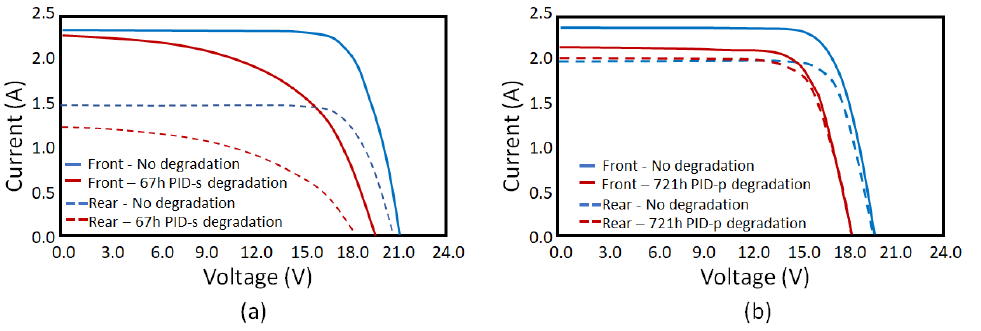
Figure 16. PID degradation effect on I-V curve. ( a ) PID-s, ( b ) PID-p [74,80]. To generate energy from both sides of the module, bifacial cells have the rear side only partially covered with metal contacts. Although it allows a photocurrent to be generated from the irradiance incident on the rear side, it affects the electromagnetic shielding of of the passivating AlO x , SiN y layers and the bulk Si [81]. As a consequence, bifacial PV cells are more vulnerable to PID. Bifacial p-PERC cells affected by bifacial PID suffer from shunting of the pn-junction (PID of the shunt type - PID-s) and an increase in the surface recombination at the rear side (PID of the polarised type - PID-p) [74]. BPV modules with double glass and EVA encapsulant are more susceptible to PID as there is an increase in the availability of Na + ions from the glass. The use of polyolefin encapsulants can prevent or reduce the occurrence of PID [82]. Additionally, studies have shown that the rear side of the bifacial cell is more affected by PID than the front side in both degradation level and degradation rate